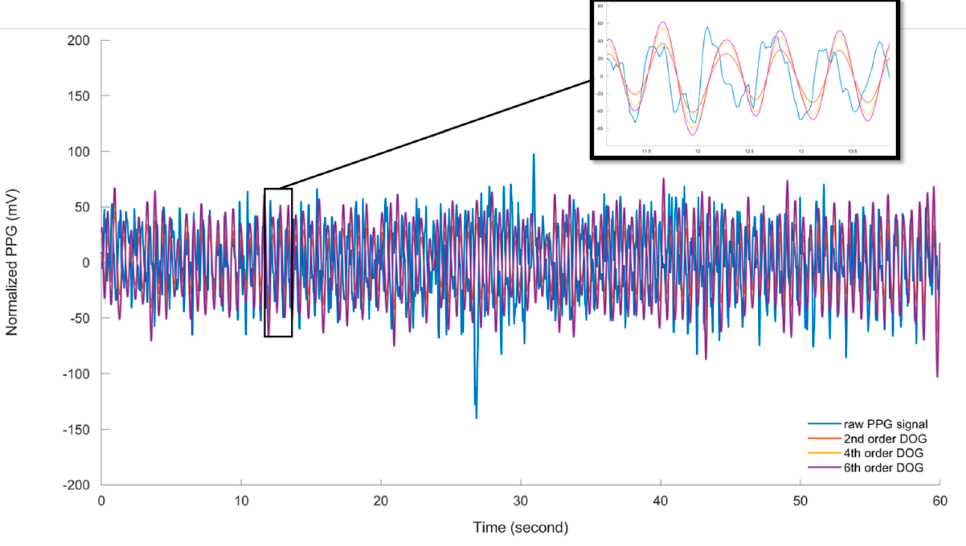
Table 1. The Mean Absolute Error (MAE) and Root Mean Square Error (RMSE) of the estimated heart rate (bpm) from all the PPG segments, in comparison to the reference pulse rate calculated from the ECG signals obtained from the anaesthetised pig. Comparing the estimated heart rate based on three orders (2, 4 and 6) of DOG wavelet.